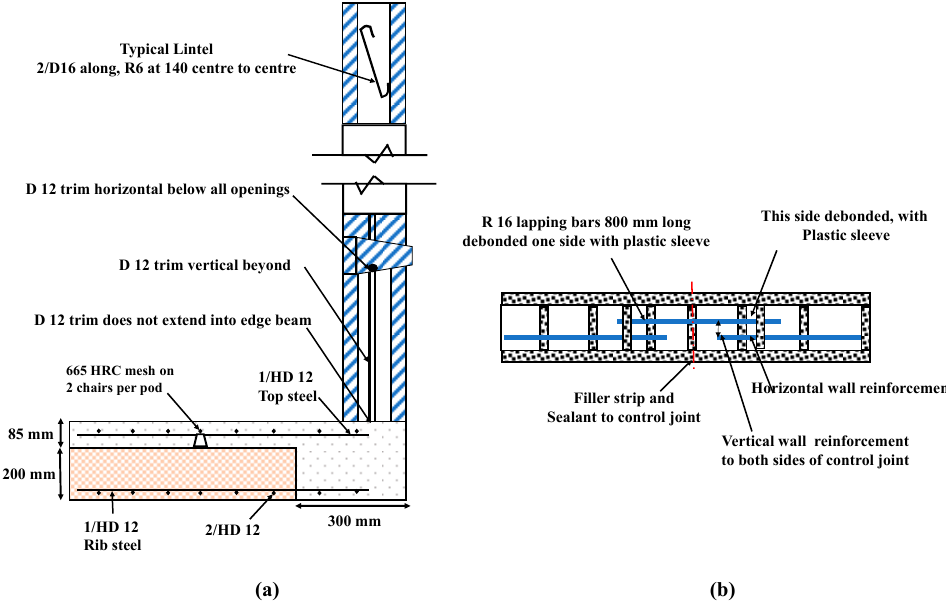
Figure 6. Connection detailing of PT masonry wall [54]: ( a ) wall to floor/foundation and ( b ) wall to wall with control joint.